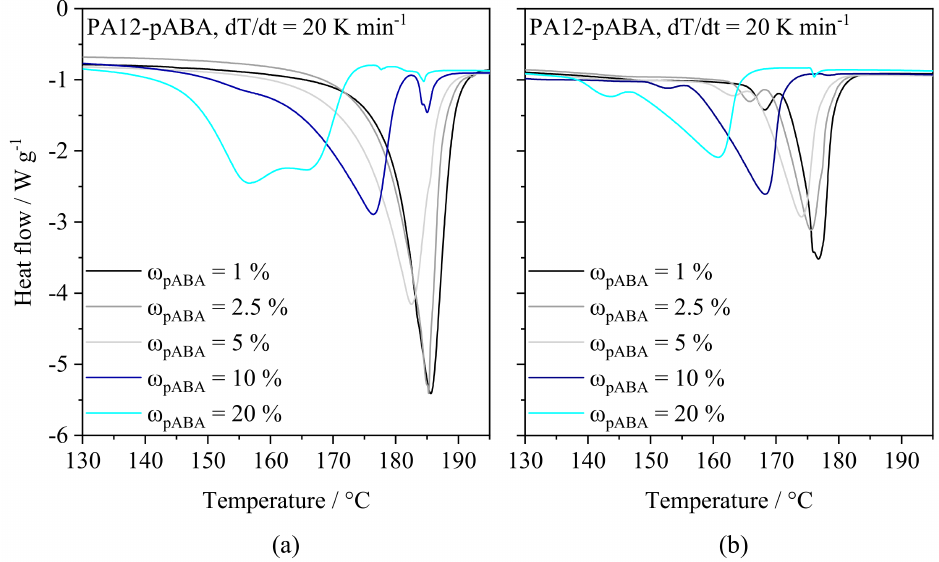
Figure 5. Differential scanning calorimetry of varying fractions of pABA observed in the first ( a ) and second ( b ) heating run, n =